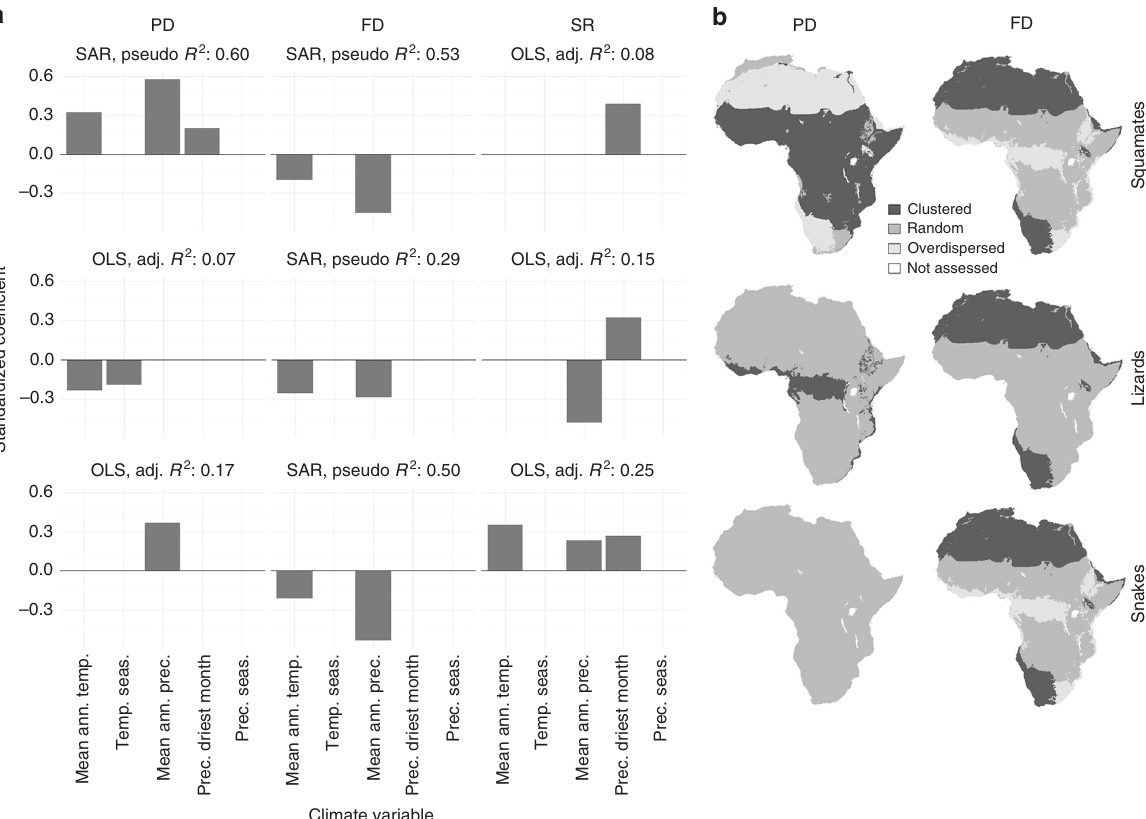
Fig. 3 Climate model coef fi cients and structuring of regional assemblages. a Standardised correlation coef fi cients of signi fi cant predictors of phylogenetic (PD) and functional (FD) diversity as well as species richness (SR) at local scale, derived from the best respective ordinary least squares (OLS) or spatial autoregressive (SAR) model. b Phylogenetic and functional structuring of biome assemblages, tested against the continental species pool (95% CI). adj. R ² adjusted R ², pseudo R ² Nagelkerke pseudo R ², mean ann. temp. mean annual temperature, temp. seas. temperature seasonality, mean ann. prec. mean annual precipitation, prec. driest month precipitation of the driest month, prec. seas. precipitation seasonality. To increase normality, temperature seasonality (Bio4) was log transformed, precipitation of the driest month (Bio14) was log(x + 1) transformed and precipitation seasonality (Bio15)